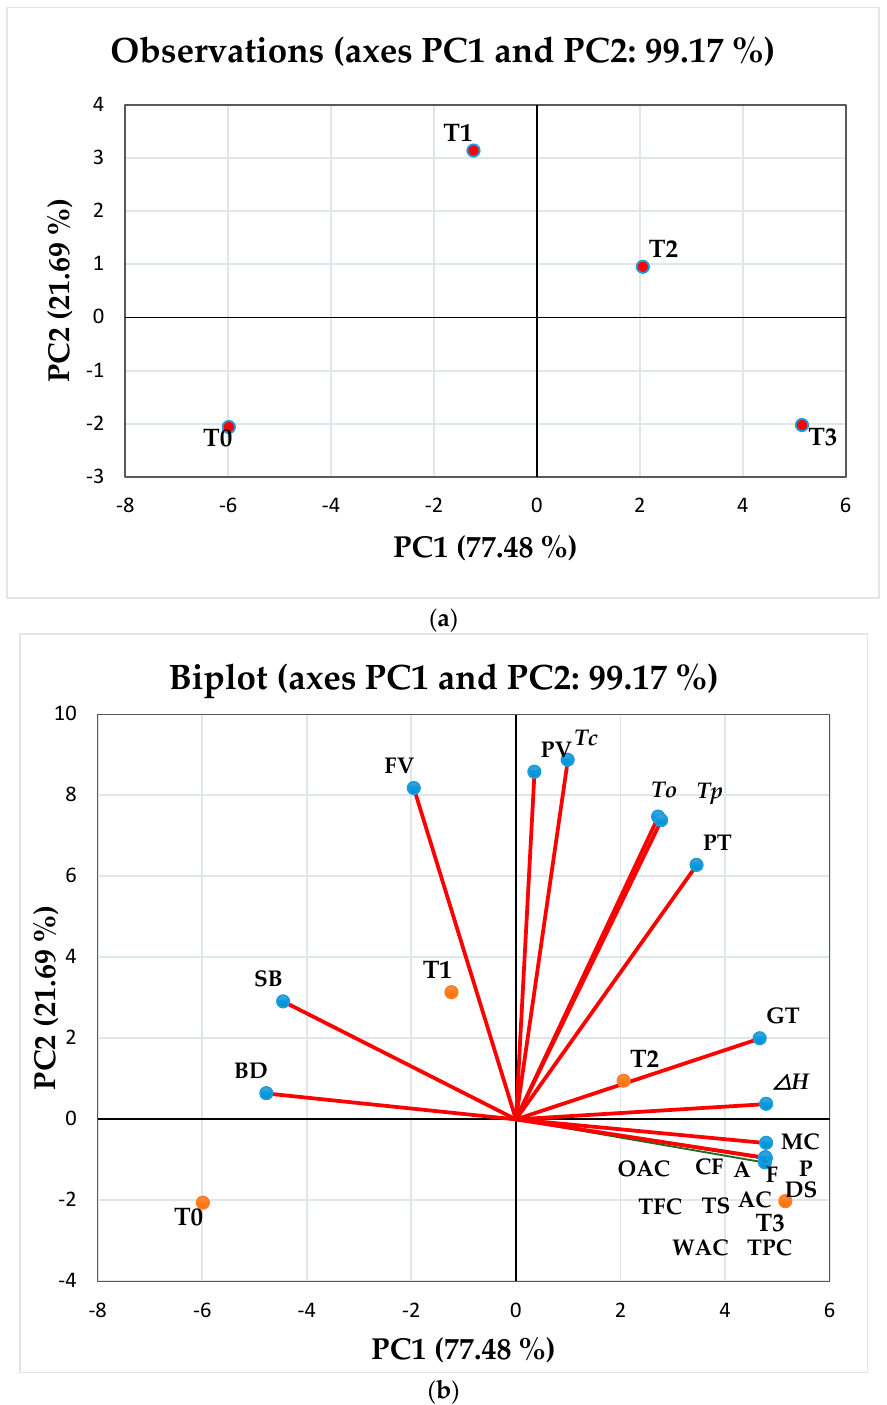
Figure 3. ( a ) Principal component analysis with the location of flour blend samples: T0; RF (rice flour): DPF (date pit flour): APF (Assyrian plum flour) (100:0:0), T1; RF: DPF: APF (90:5:5), T2;